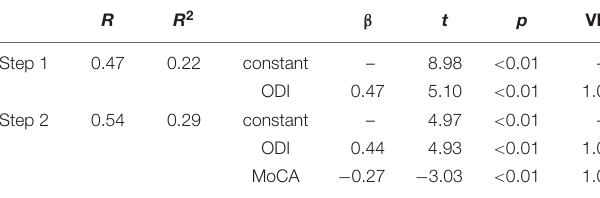
TABLE 3 | The results of multiple linear regression analysis.